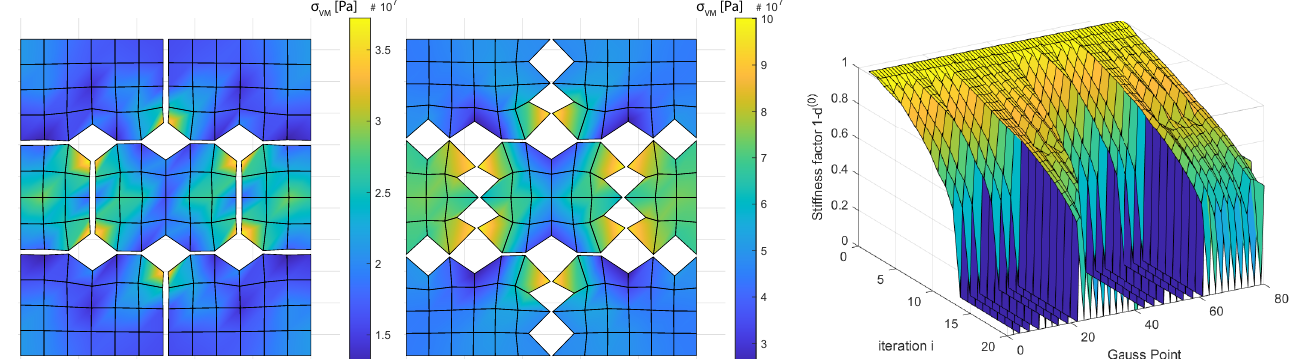
Figure 8. Failure according to von Misses energy criterion. From left to right : region 2 a before failure, one step after failure and stress reduction after damage law expansion. Micro-scale deformation magnification 10 × . G = 10 14 Pa. After obtaining the different failure envelopes for different crack stiffnesses G the range presented in (Figure 3), which was issued from previous results, can be further refined (Figure 9).